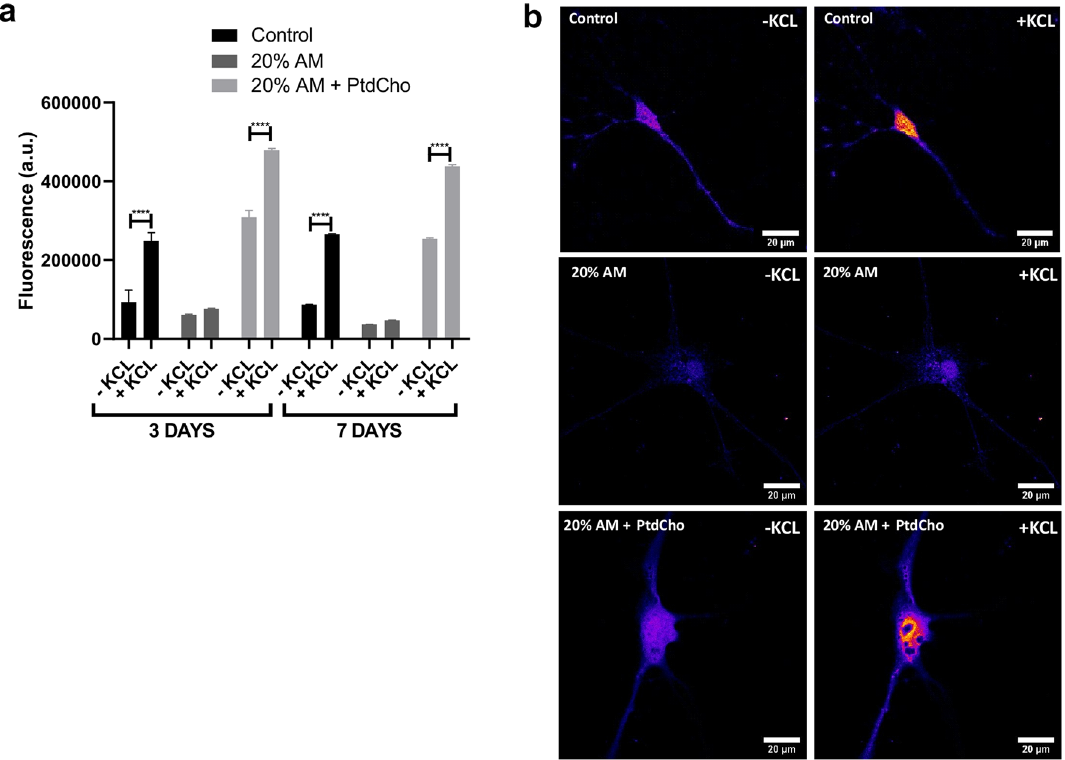
Figure 6. Stress affects neurons depolarization. ( a ) Cells were incubated under the indicated condition during 3 or 7 days and loaded with Fluo-3AM. Graph represents fluorescence as arbitrary units (a.u.) detected before and after treatment with KCl. Values are expressed as mean ± SEM ****p < 0.0001. ( b ) Representative images (× 63) of neurons labelled with Flio-3AM before and after KCl treatment. Scale bar 20